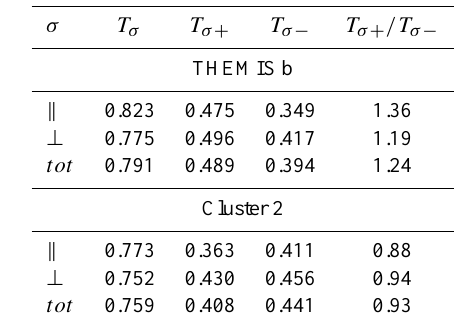
Table 1. Temperature contributions, T + and T − (10 6 K) calculated by integrating Eqs. (4) and (5) over pitch angles α . T tot is 1 2 T ⊥ ) .